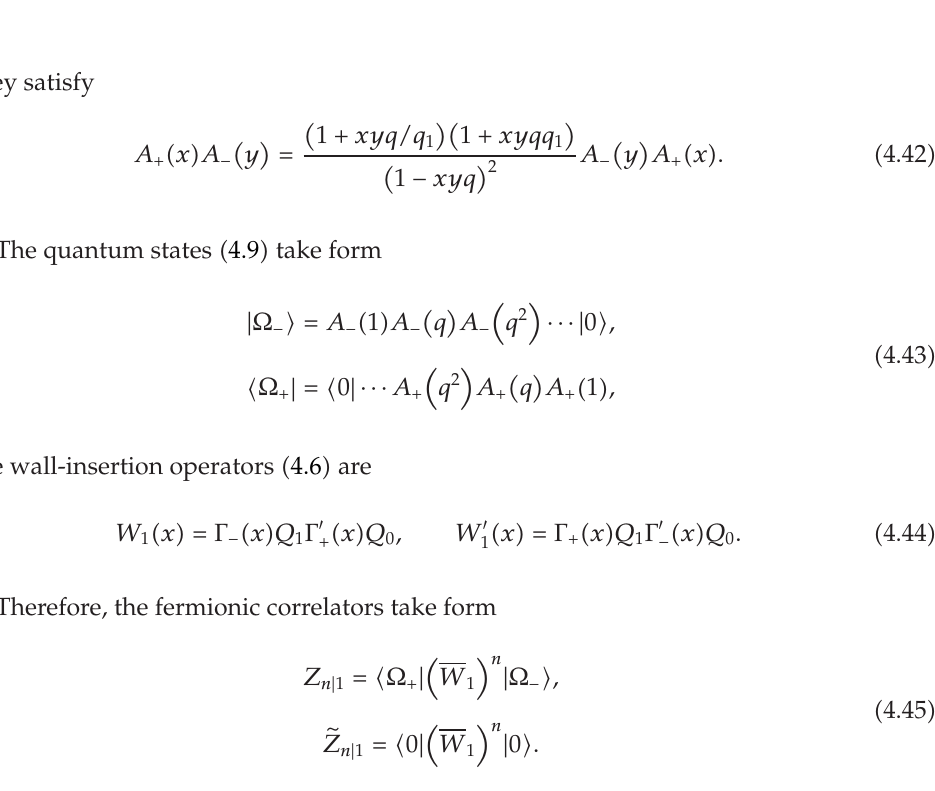
Figure 13: Conifold crystal in the chamber with positive R and 2 < B < 3 takes form of pyramid partitions with 3 stones in the top row. Its generating function is given by Z 2 | 1 (cid:7) (cid:18) Ω (cid:9) | (cid:4) W 1 (cid:5) 2 | Ω − (cid:15)